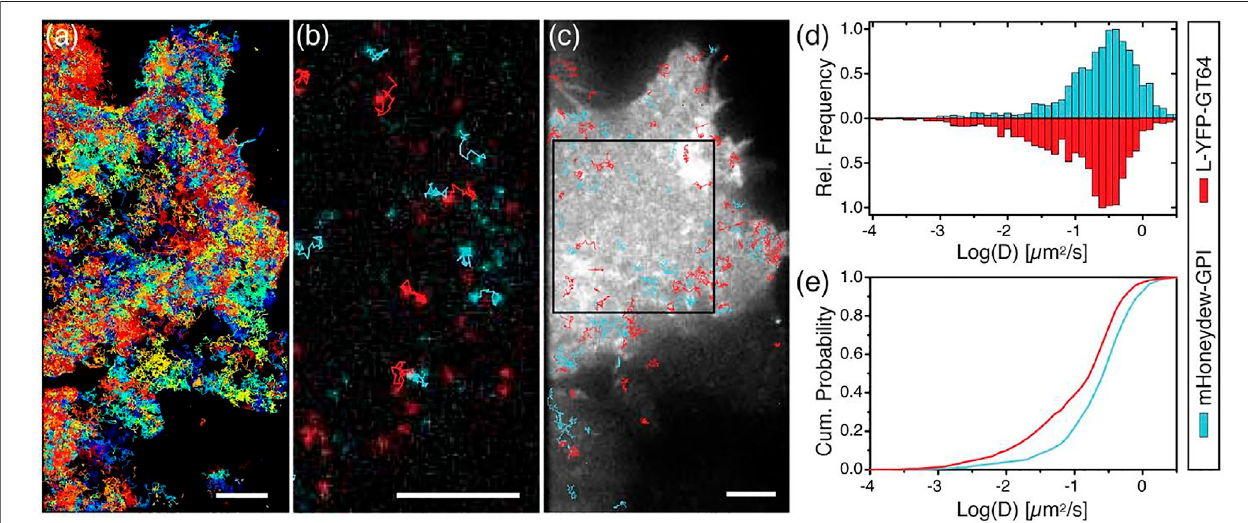
FIGURE 3 | Single particle tracking of human bone osteosarcoma (U2OS) cells. (A) Fluorescent image of cells expressing L-YFP-GT46 (red-tracks) overlaid with tracks > 5 frames. (B) Dual-color single particle tracking experiment. Image is a fl uorescence micrograph showing tracks between two time points ~0.75 s apart. (C) Fluorescent image of the YFP fl uorescence of the cell overlain with blue and red dual fl uorescent tracks with lengths of 30 – 40 frames. (D) Frequency histogram of log of diffusion coef fi cients for each probe type. (E) Cumulative probability plot for the diffusion coef fi cients. Scale bars are 5 microns. Figure adapted from Albrecht, David,etal. “ DualColorSingleParticleTracking via Nanobodies. ” MethodsandApplicationsinFluorescence,vol.3,no.2,2015,p.024001.,doi:10.1088/2050-6120/3/ 2/024001. Original work is available for use under the Creative Commons CC BY 3.0